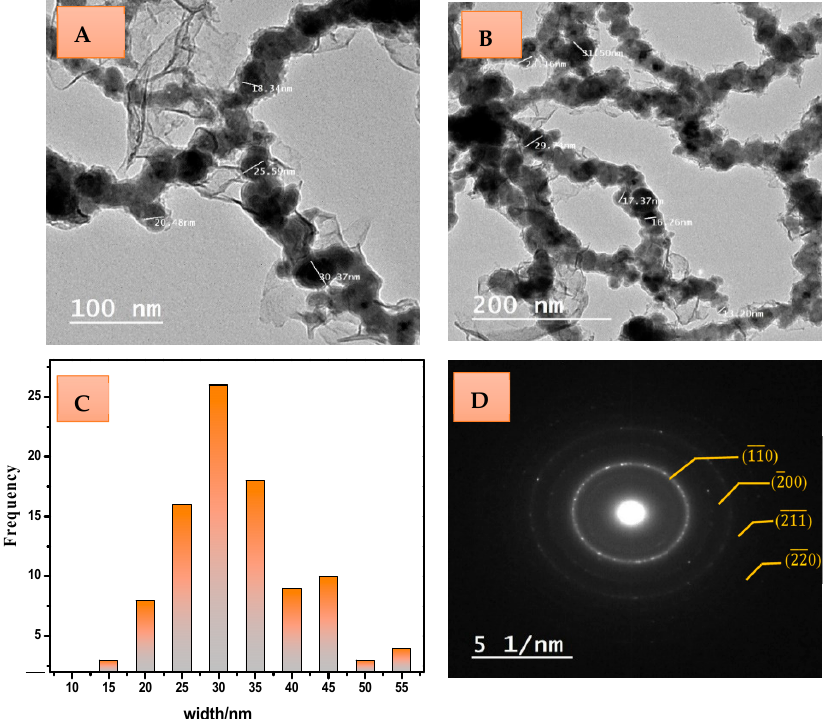
Figure 2. TEM images at different magnifications ( A , B ); histogram of the nanoparticle width ( C ); and SAED image ( D )of nZVI